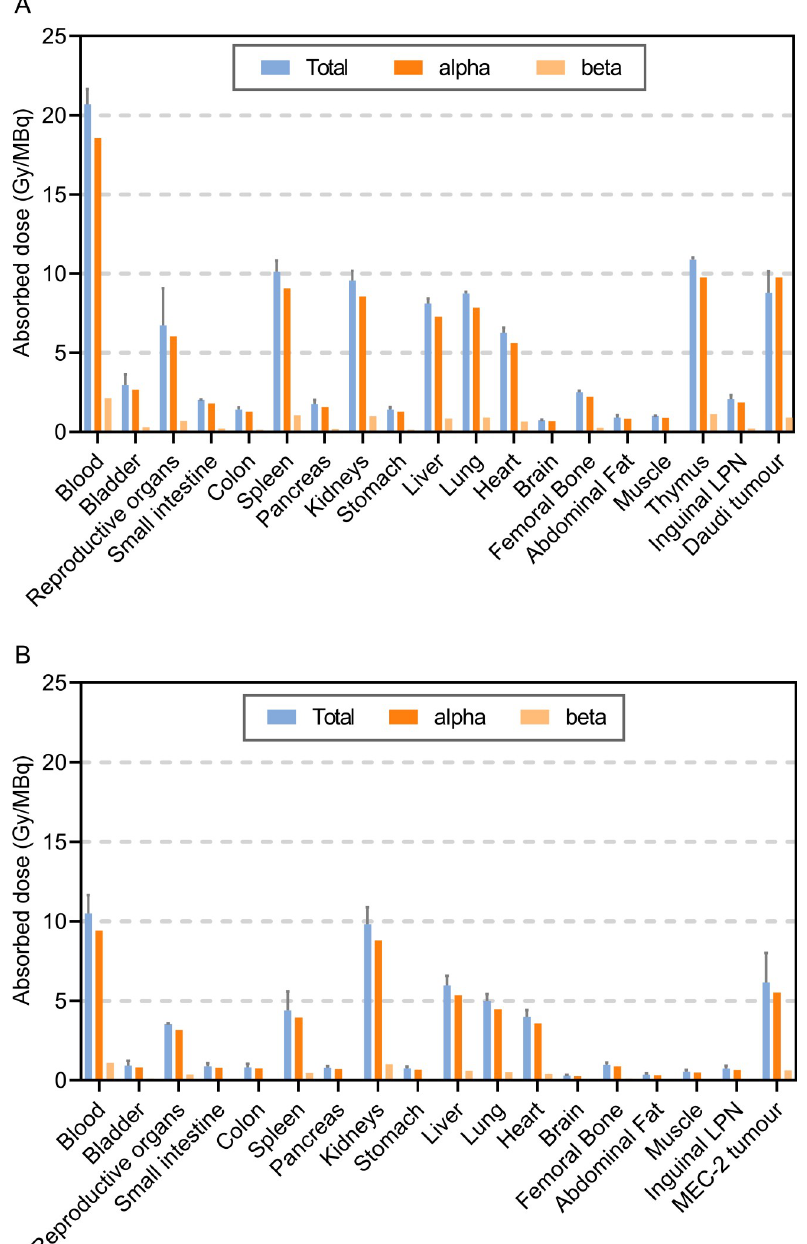
Fig 3. Dosimetry of 212 Pb-NNV003. Absorbed radiation dose (Gy/MBq) to tissues of (A) CB17 SCID mice with Daudi s.c. xenografts (n = 5 per time point) and (B) R2G2 mice with MEC-2 s.c. xenografts (n = 4 at 6 h, n = 10 at 2 and 24 h). Error bars = SD of total absorbed radiation